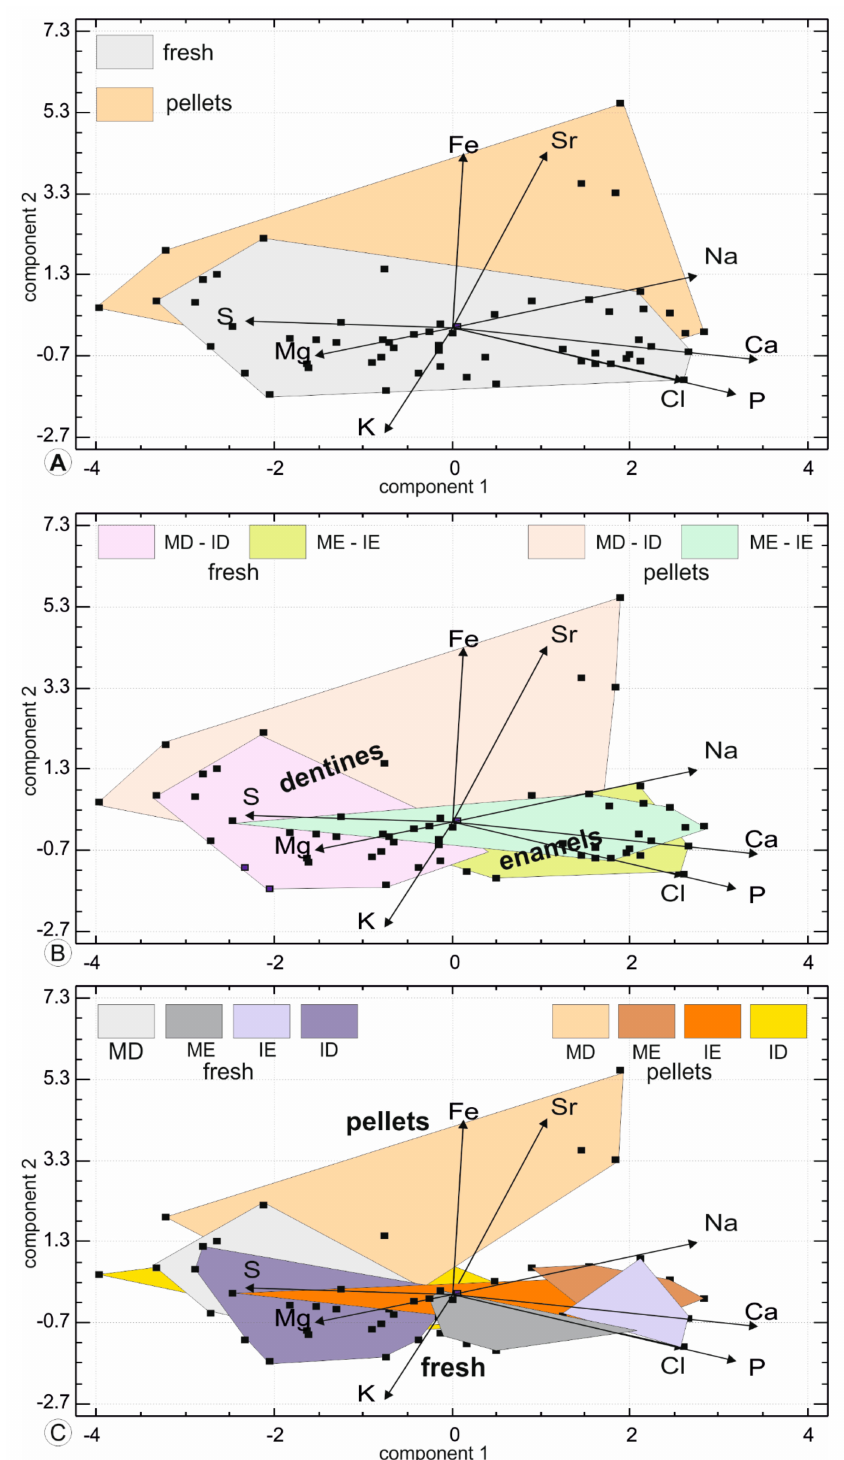
Figure 11. Principal component plot based on the chemical compositions of fresh and digested teeth. ( A )—Samples di ff erentiated following their origin (fresh, digested). ( B )—Samples di ff erentiated following their origin and tissue (dentine, enamel). ( C )—Samples di ff erentiated following their origin and tissue (dentine, enamel) and tooth (incisor, molar). ME: molar enamel, IE: incisor enamel, MD: molar dentine, ID: incisor